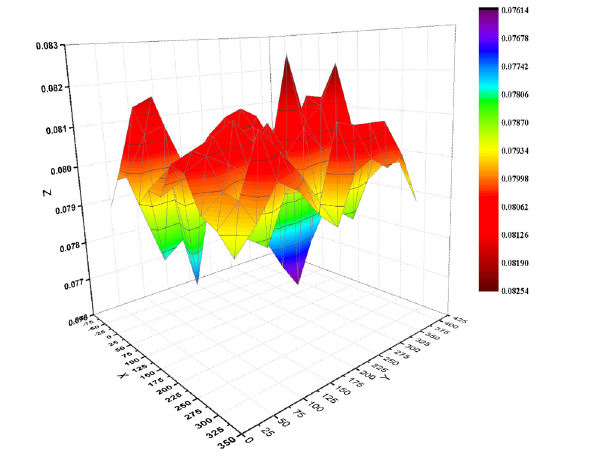
Figure 3: The potential energy scan picture the IPAONM